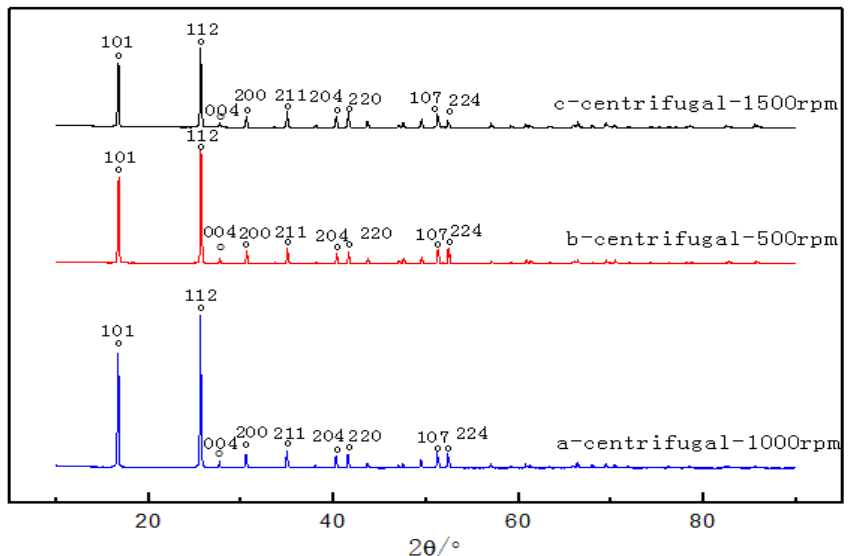
Figure 5. SEM images of NH 4 ReO 4 particles at different centrifugal speeds: ( a ) 500 rpm, ( b ) 1000 rpm, ( c ) 1500 rpm.